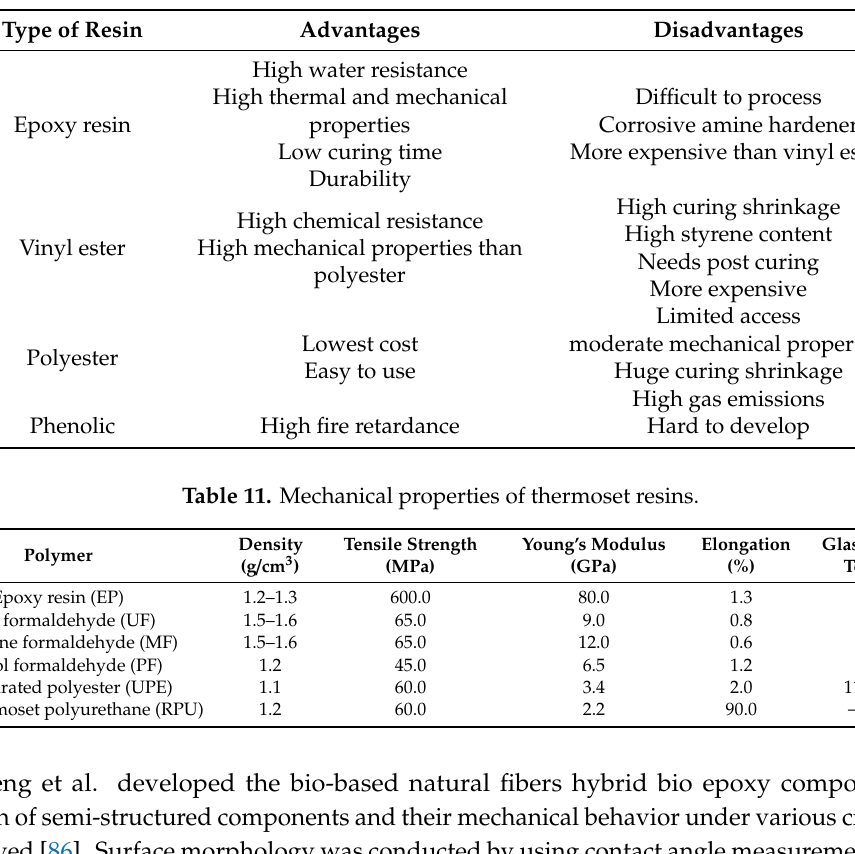
Table 10. Merits and demerits of thermoset resins.